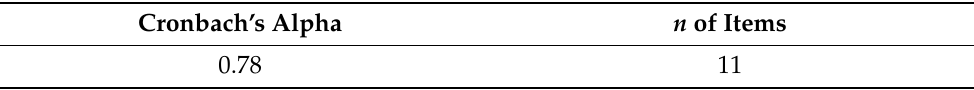
Table 7. Cronbach’s alpha coefficient value for fidelity